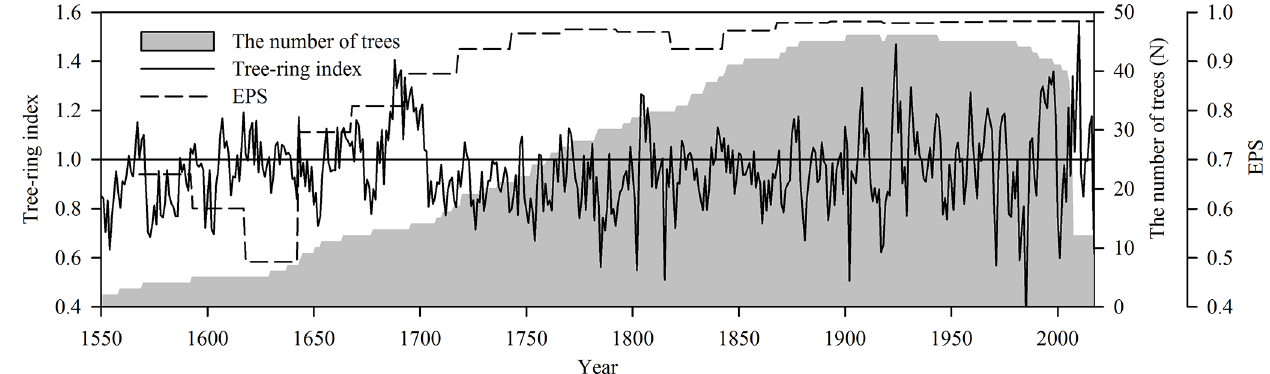
Figure 3. The regional tree-ring width chronology from 1550 to 2017 in the Chitral, Hindu Kush mountains, Pakistan. The gray area represents the sample depth.